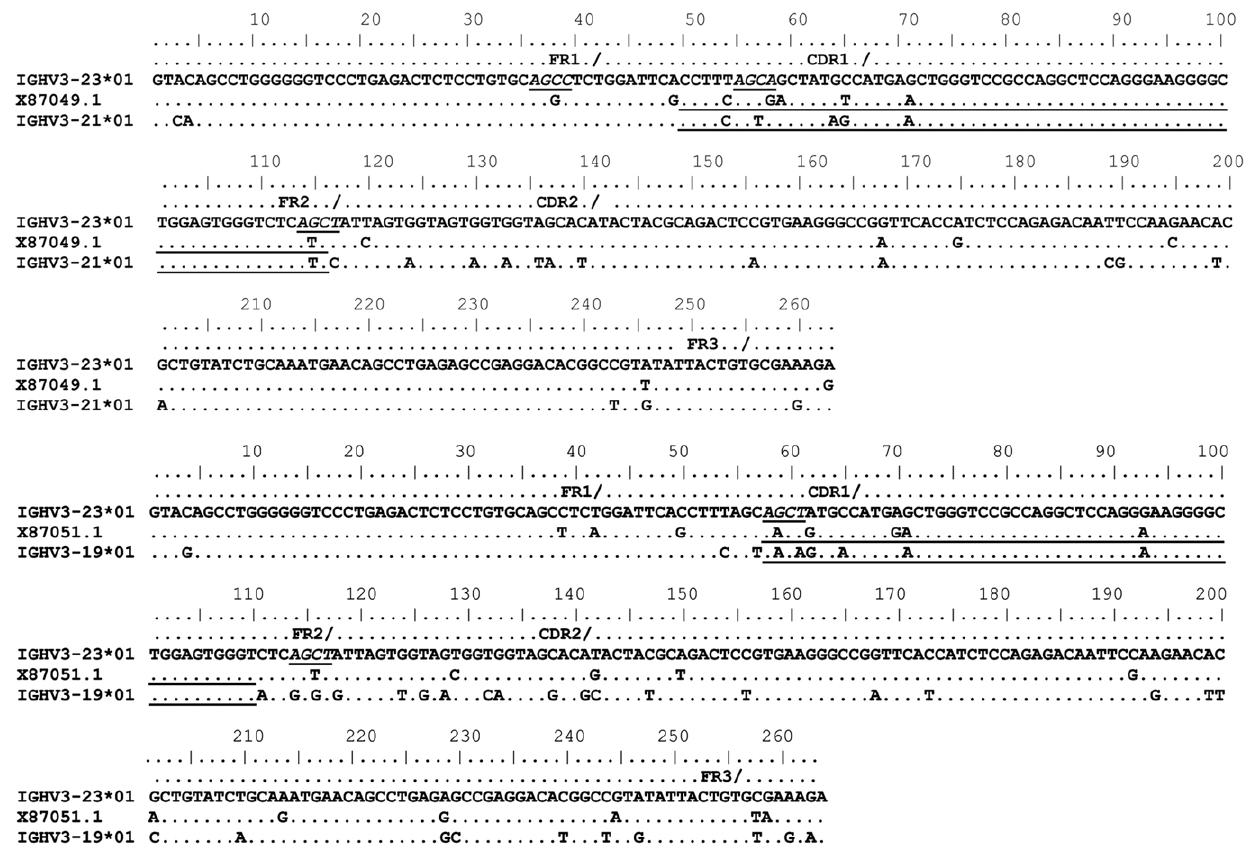
FIGURE 2 | Gene conversion-like events between rearranged IGHV3-23*01 gene sequences and germlineVHsequences superimposed by somatic hypermutation (SHM). IGHV3-23*01 mutated sequences obtained by single-cell PCR from CD19 + IgM + B cells (Brezinschek et al., 1995, 1997; Dörner et al., 1998; Longo et al., 2008).Topmost sequence is